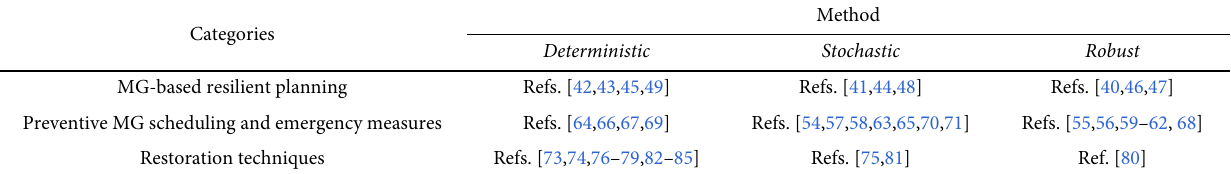
Table 3 Classification of methods according to modelling